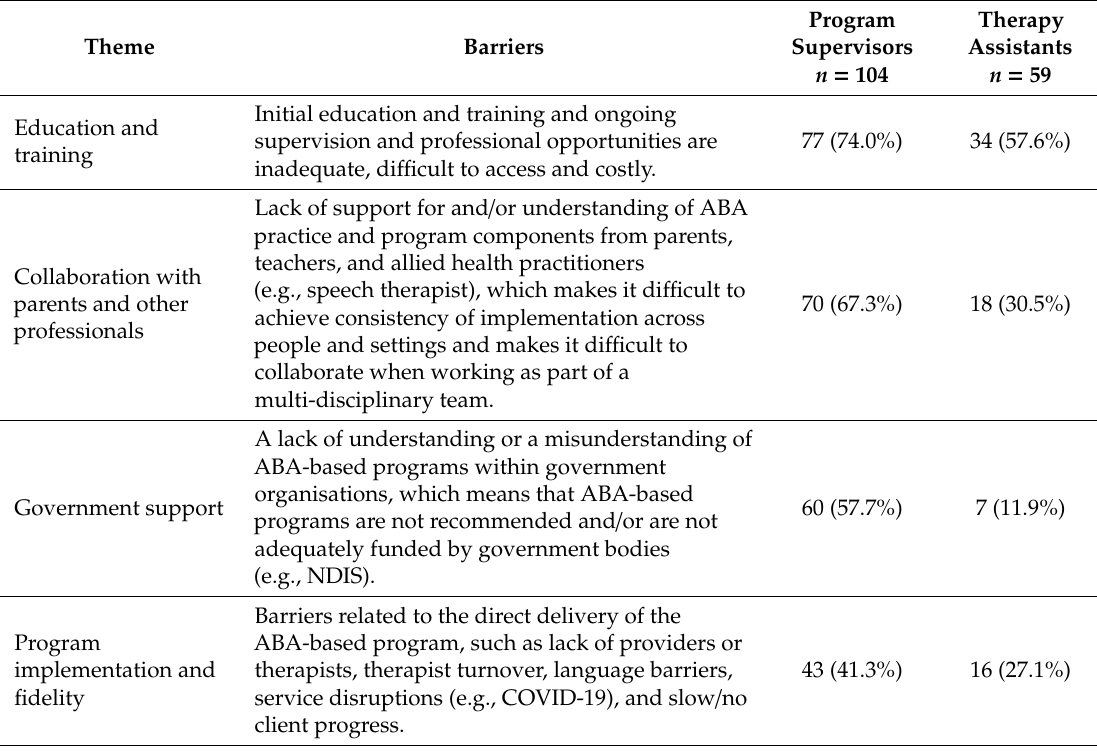
Table 5. Thematic categories and definitions of barriers, and frequency with which barriers in each thematic category were identified by program supervisors and therapy